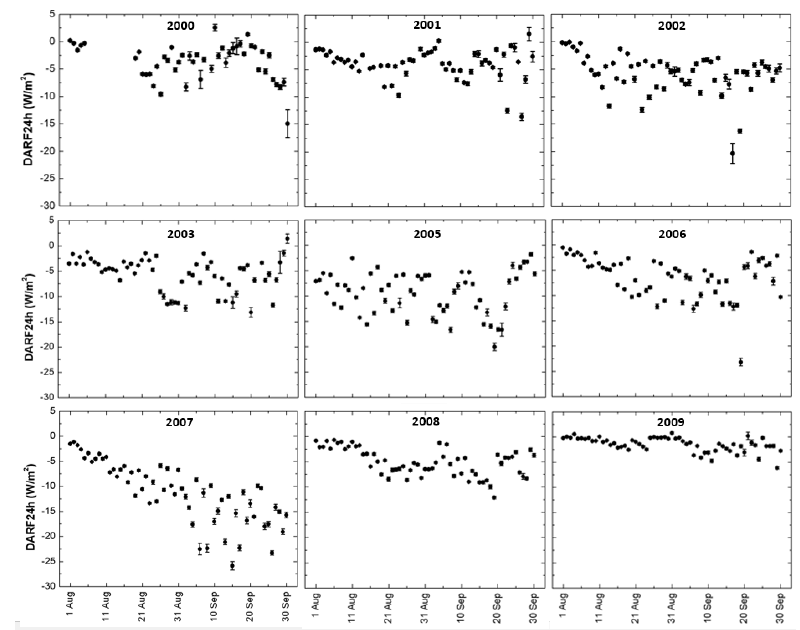
Figure 3. Temporal variability of the direct radiative forcing of aerosols (24h-DARF) along the biomass burning seasons of 2000 to